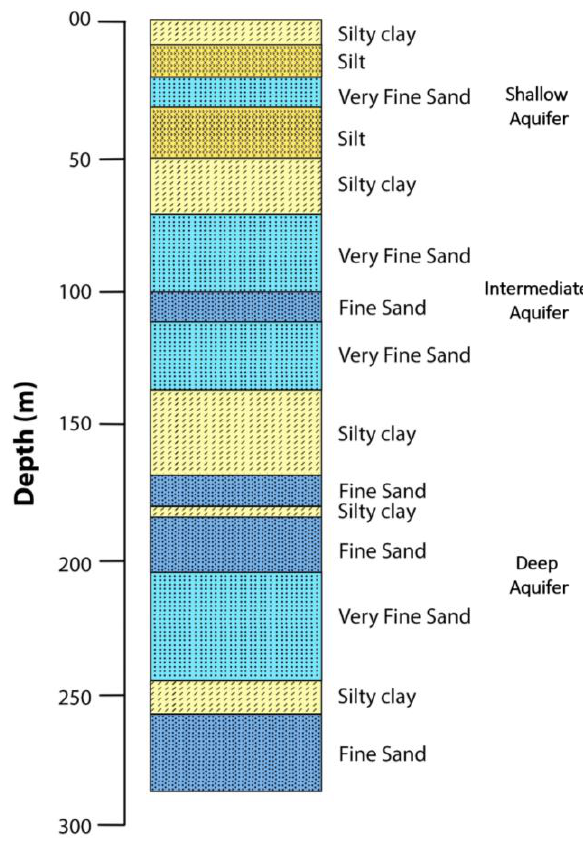
Figure 2. Cross-section of the underlying lithology.